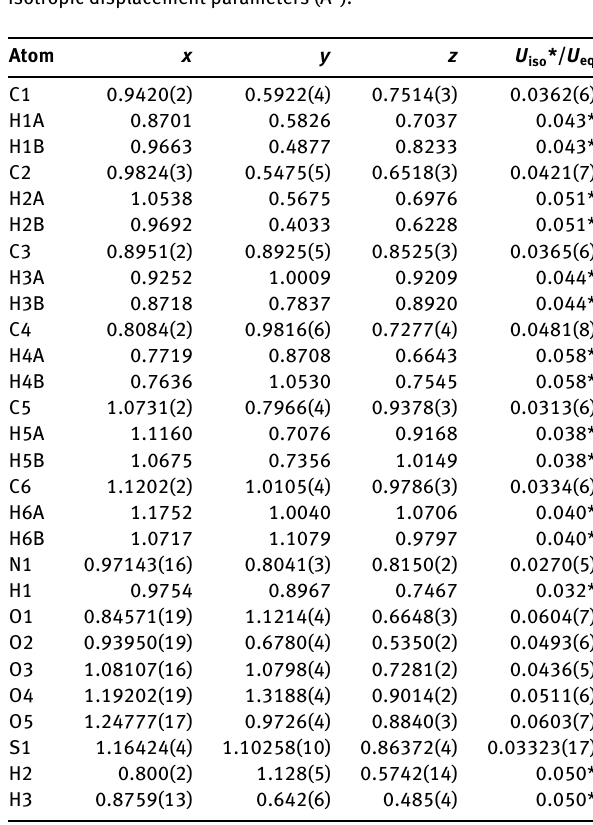
Table 2: Fractional atomic coordinates and isotropic or equivalent isotropic displacement parameters (Å 2